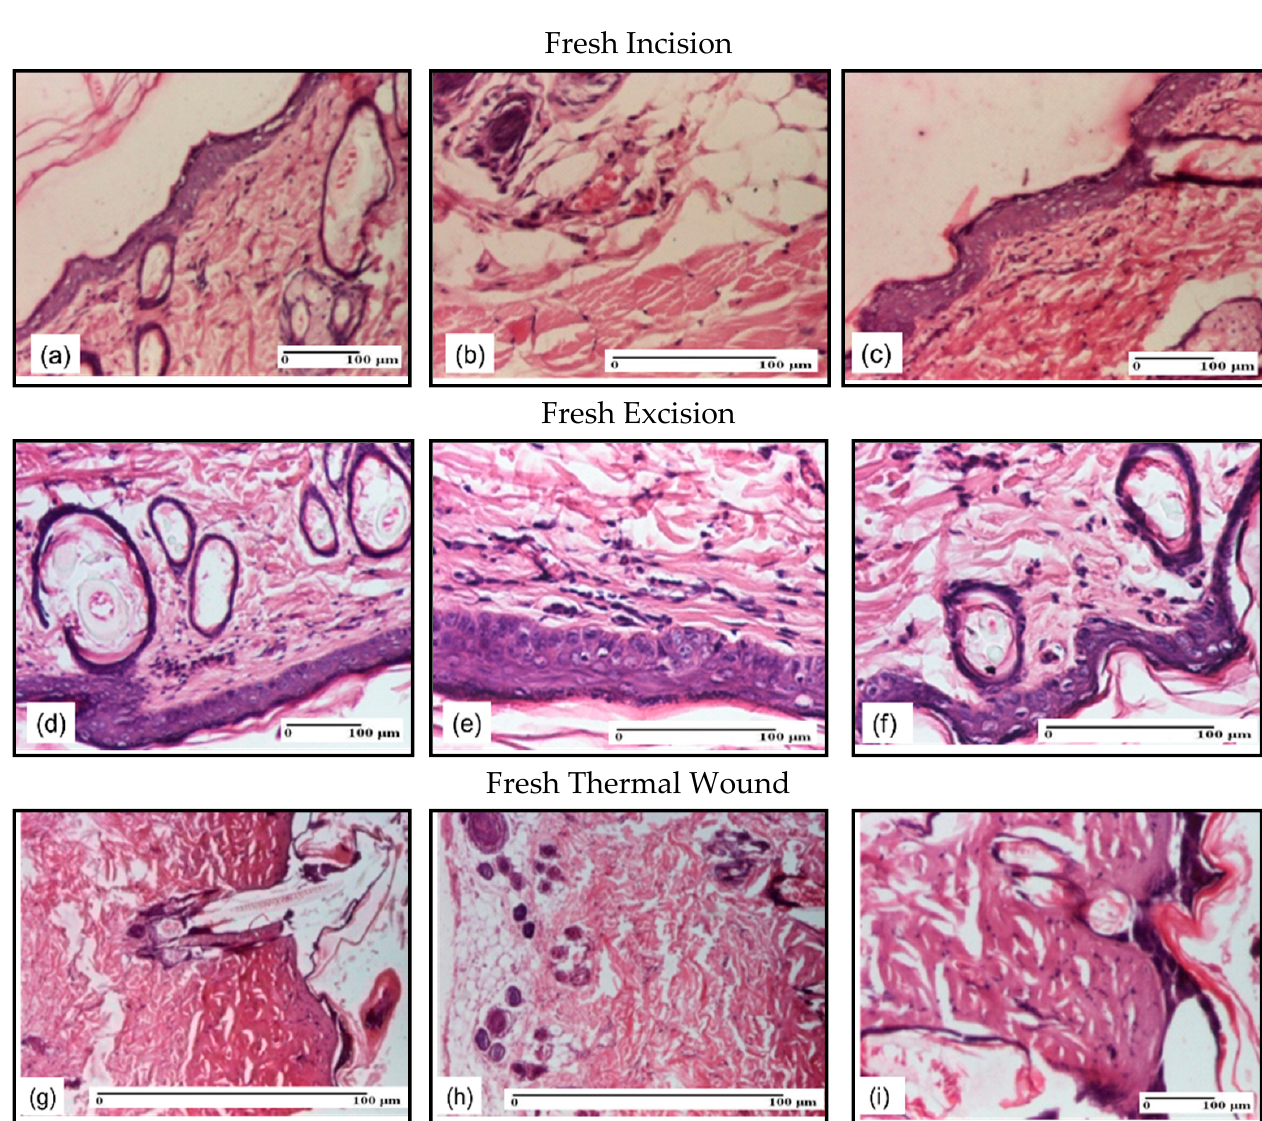
Figure 5. Microscopic histology images of fresh cutaneous wounds models: ( a ) Rare lymphocytes (S1); ( b ) Vessel